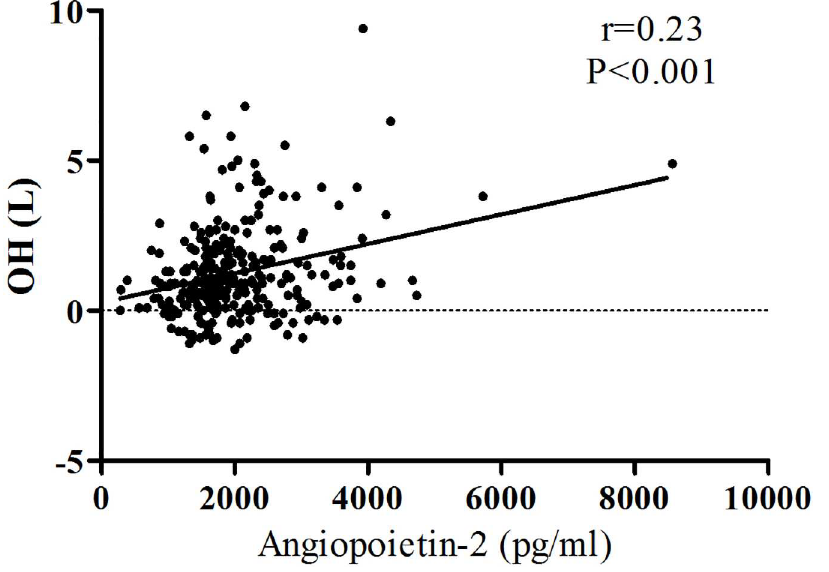
Fig 1. The correlation between circulating angiopoieitin-2 level and fluid